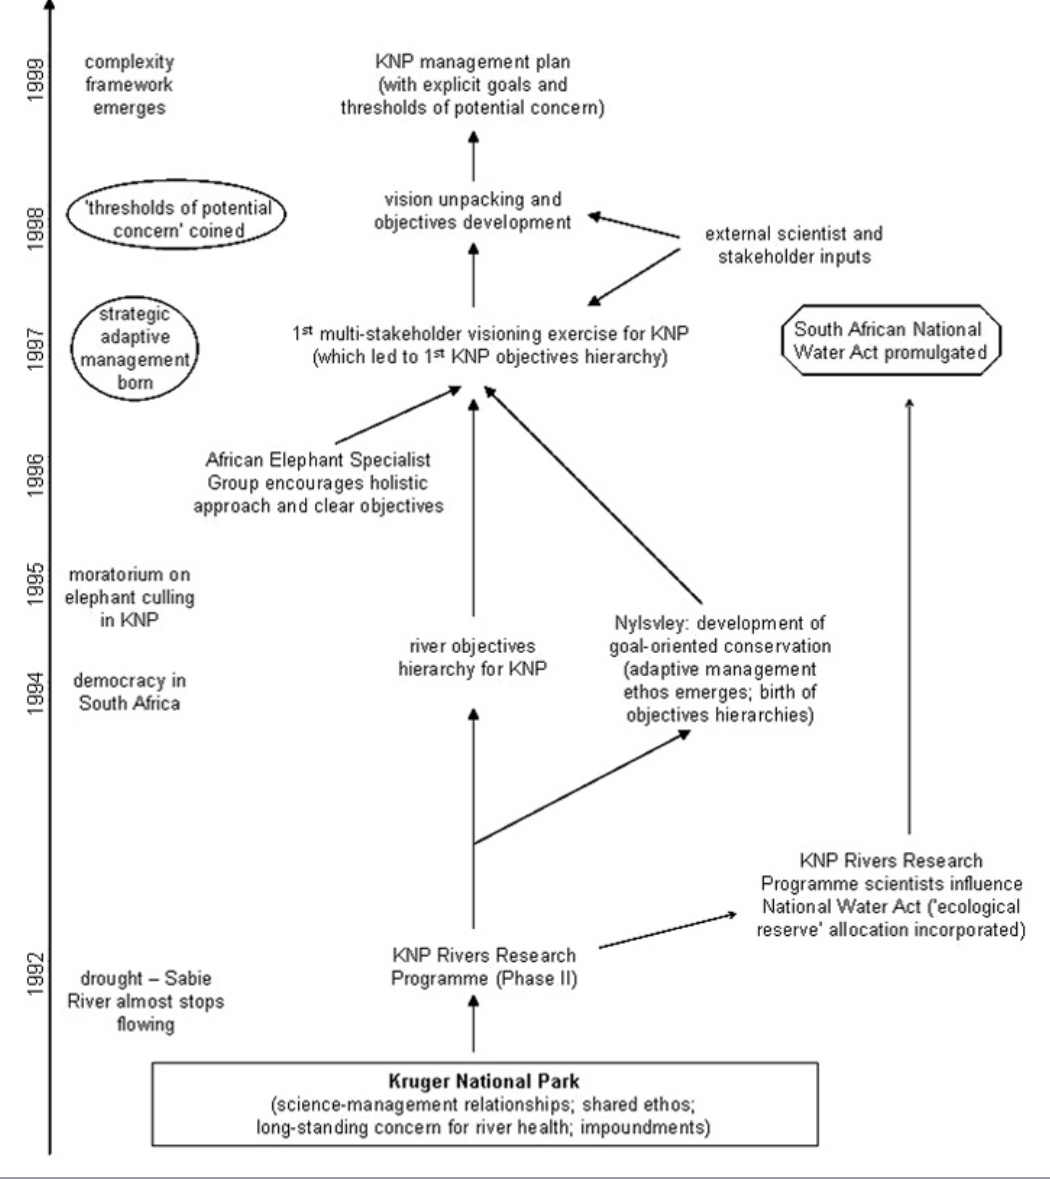
Fig. 2 . Simplified chronology of events, experiences, interactions, and influences around the initiation and spread of strategic adaptive management approaches within and around the Kruger National Park through the 1990s. Solid arrows denote direct influence and